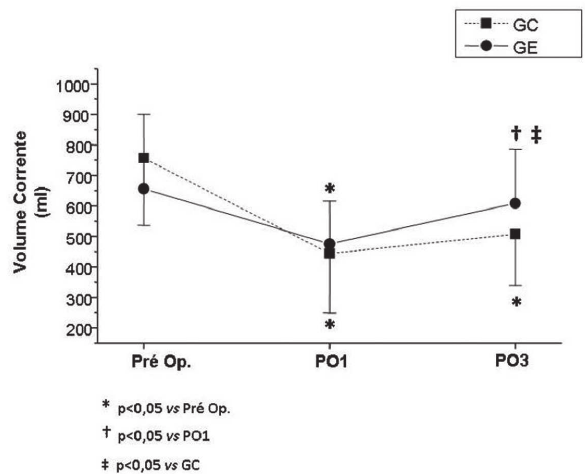
Fig. 3 - Evolução do valor do volume corrente nos grupos estudados. Volume corrente. GC = grupo controle, GE = grupo estudo, VC = volume corrente